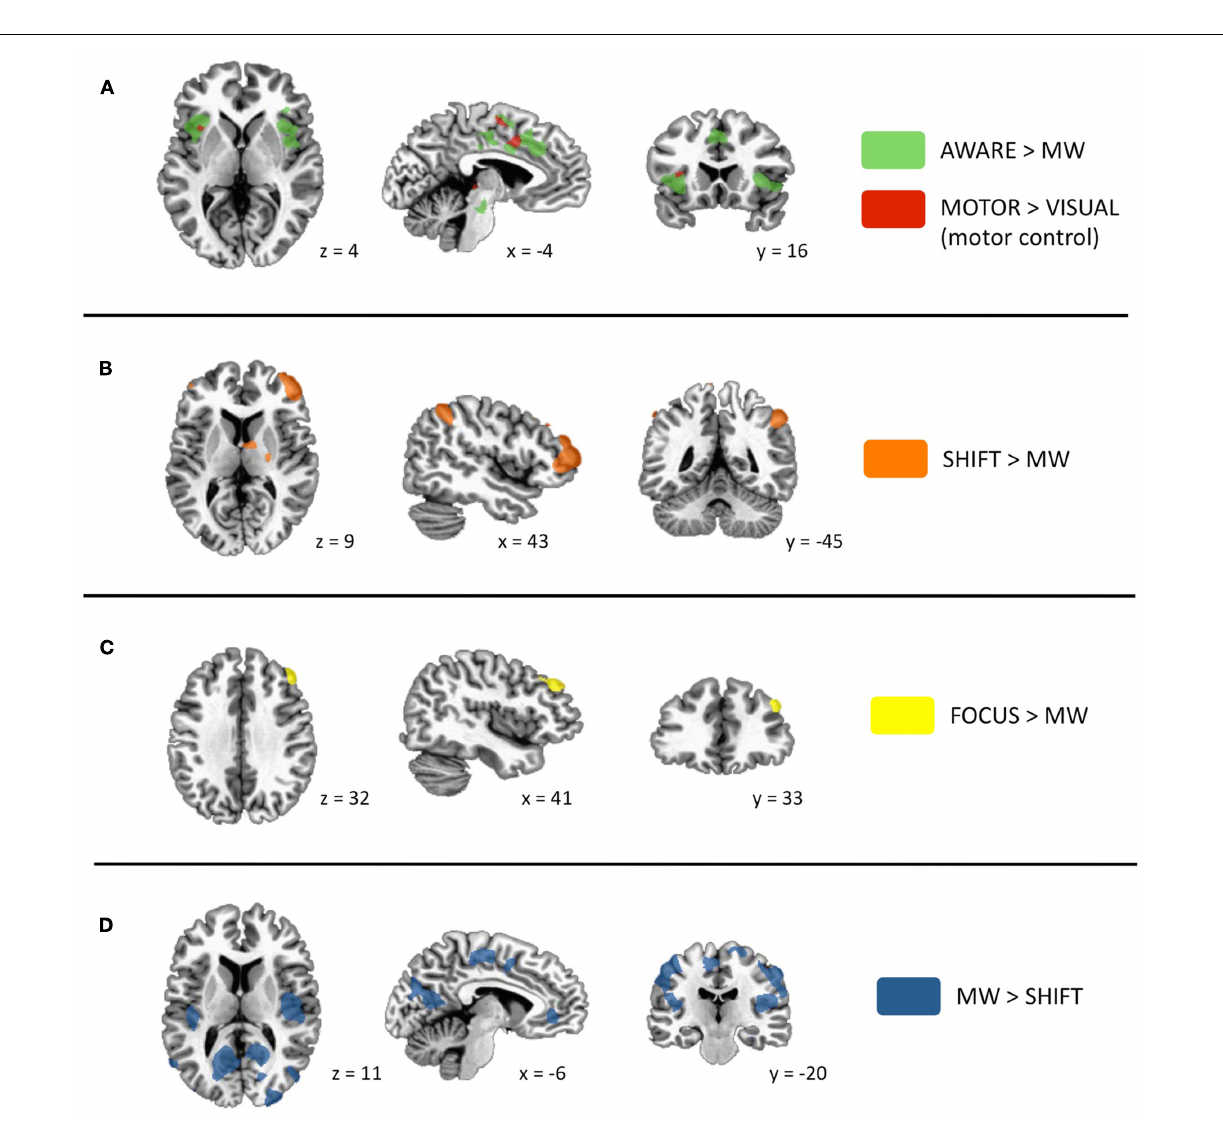
FIGUREA2 | Significant activations for phases of interest. Specific contrasts are listed in each panel. (A) Activations during the AWARE phase are in green (due to highly robust activations, this contrast was thresholded to p < 5.0 × 10 − 6 ). As the button press occurred during this phase, voxels that were also significantly active during a motor control task (motor > visual; p < 0.005) are shown in red. Prominent activity was detected in dorsal ACC